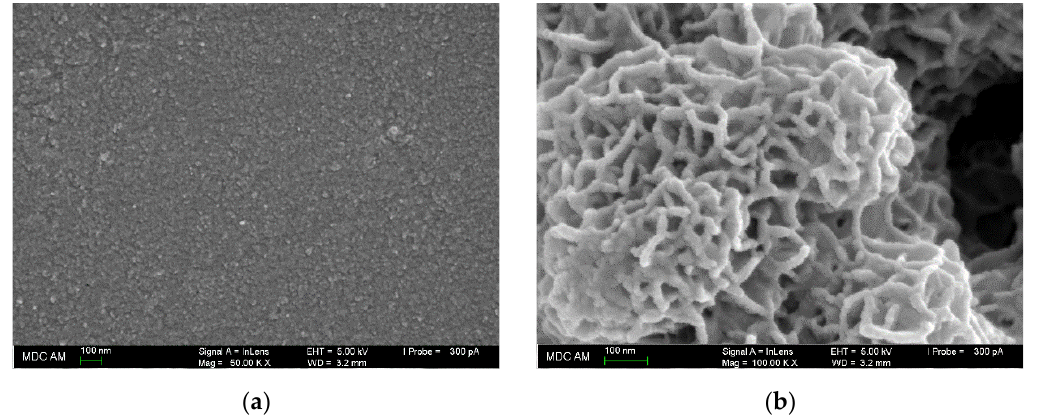
Figure 3. Surface morphology of the electrodes based on SEM: ( a ) bare GCE; ( b ) MnO 2 nanorods- modified GCE.